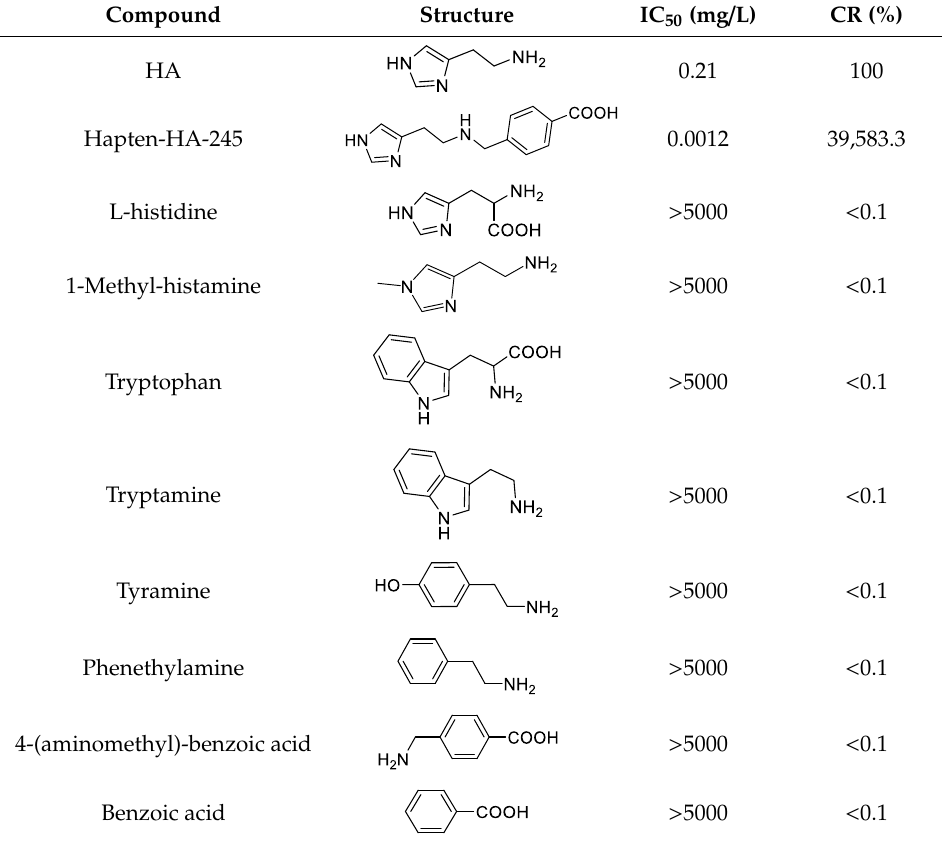
Table 2. The cross-reactivity of anti-HA Mab with HA and related compounds.